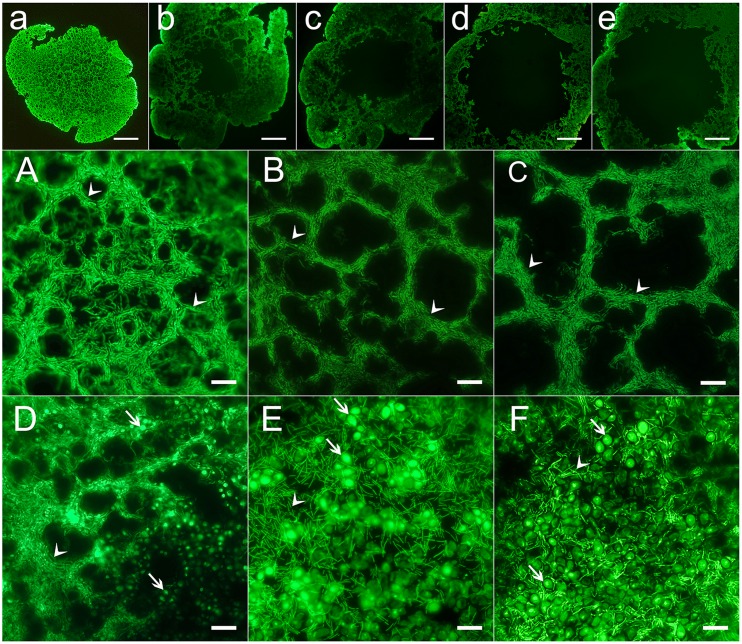
The microflora in TKGs observed on thin sections stained with SYBR Green I.(a–e) Series thin sections, from outside towards inside, of a single hollow globular unit. Scale bar = 500.0 µm. (A–C) The polyhedron-like net structure, from outside towards inside, of a grain unit. (D–F) The distribution of yeasts on the outside wall of a grain unit. The arrows indicate the representative yeast cells. The rod-shaped cells (A–F) are bacteria as marked with the arrowheads. Scale bar = 10.0 µm.